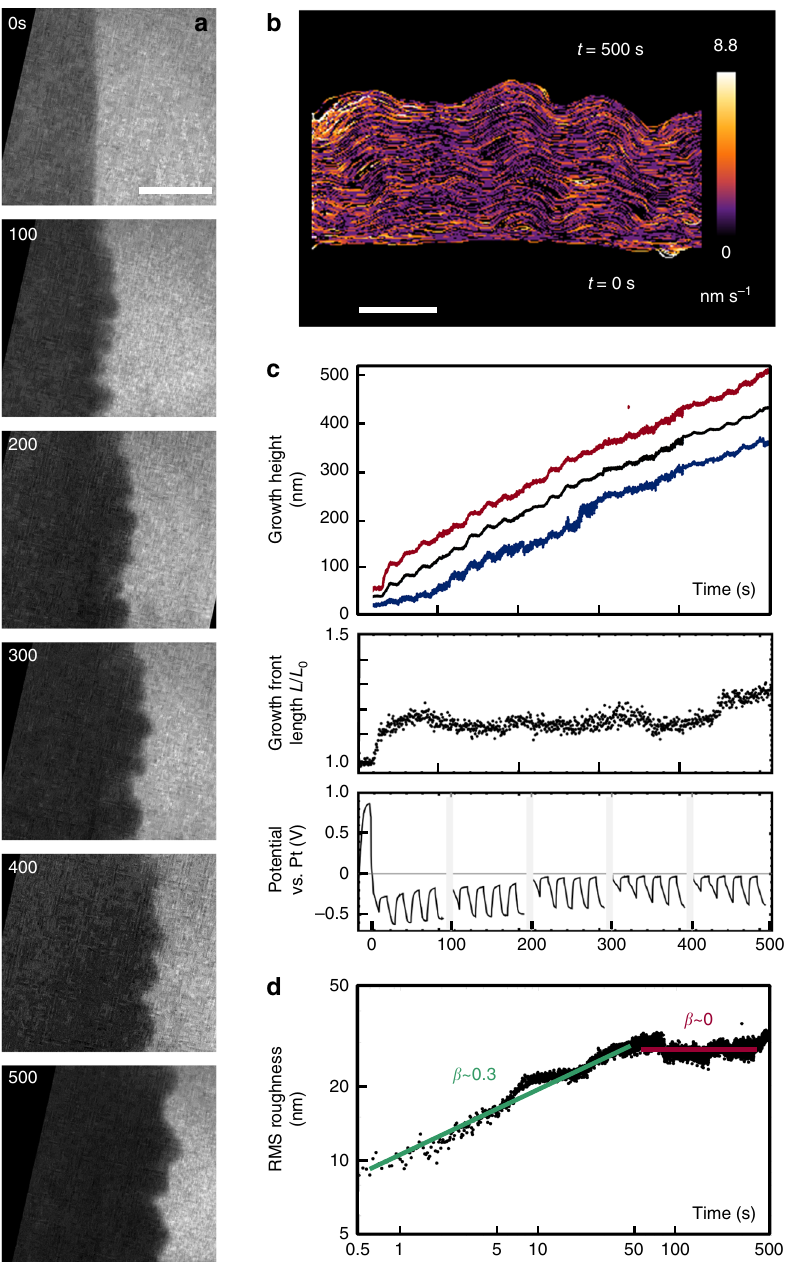
Fig. 2 Electrochemical deposition of Cu at lower growth rate. a Bright- fi eld images extracted from Supplementary Movie M2. The electrolyte is the same as in Fig. 1, but with cycles of 75 nA for 10 s/zero current for 10 s applied repeatedly after an initial cleaning cycle of 15 s. Time t = 0 indicates the end of the initial cleaning cycle. An image is shown then and after every fi ve current pulses. Each set of fi ve pulses takes 100 s and there is a longer interval between each set that is not included in the indicated time. Scale bar 300 nm. b Interface position from movie frames, color coded by normal growth speed. Scale bar 200 nm. c Structural and electrical data as a function of time: growth height (black = average, red = maximum, and blue = minimum), relative length of the growth front, and potential. In the potential, the initial peak is associated with the electrode cleaning cycle; the gray bars indicate the intervals between groups of fi ve current pulses. The average growth rate during the on-time is 1.3 nm s − 1 , equivalent to current density 35 A m − 2 . The staircase shape of the growth front position re fl ects the growth-pause cycles. Slow etching (more than 10 × slower) retracts the growth front slightly during times of zero current (Methods). d RMS roughness of the growth interface shown as a log – log plot with best- fi tting straight lines and exponents. The off time is included to re fl ect that diffusive behavior is governed by the total